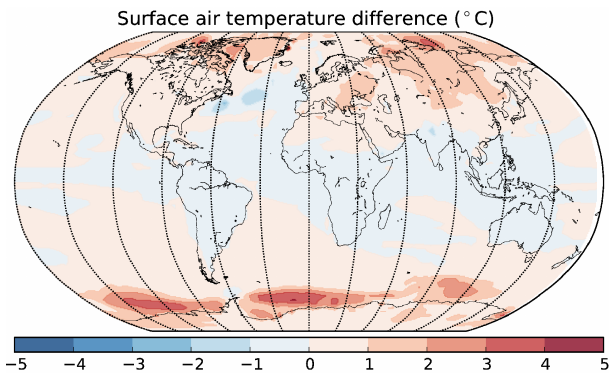
Figure 11. Sea surface temperature difference for two idealised simulations. CO 2 concentration, glaciation level and precession re- mained fixed, the only difference being obliquity (23 and 24 ◦